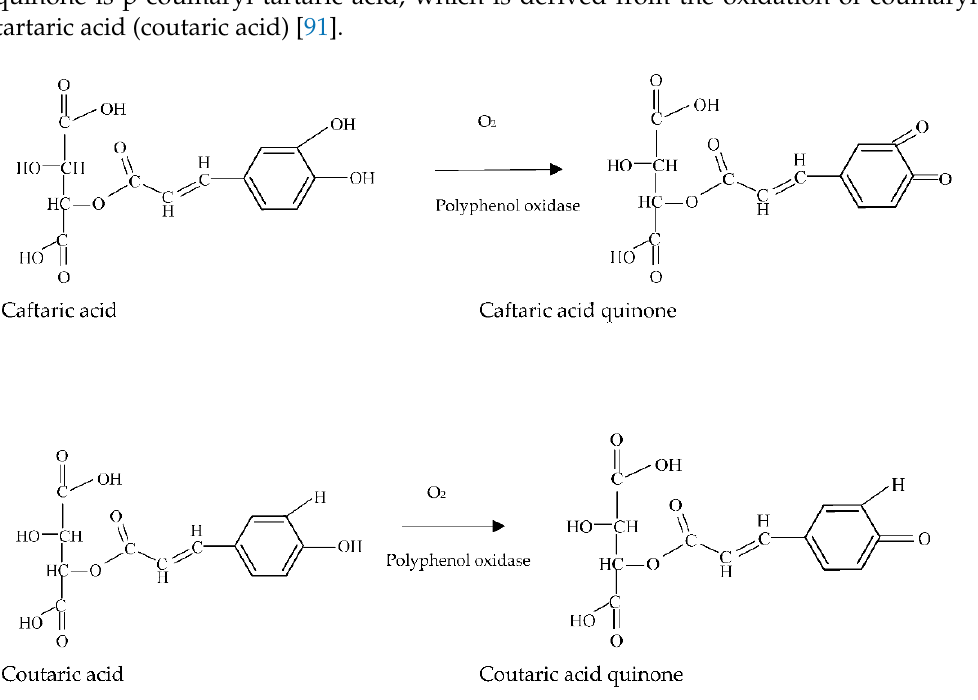
Figure 4. Enzymatic oxidation reactions of caftaric and coutaric acids in must and wine, based on Moreno and Peinado [91].